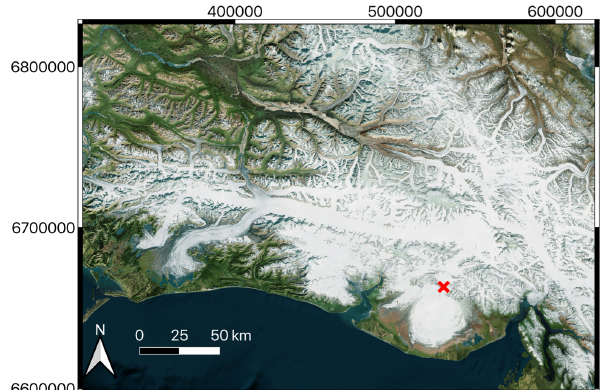
Figure 19. Optical image of the Malaspina Glacier in Alaska, where the red cross marks the location over the fast-moving glacier outlet for the validation of the velocity estimates against other prod- ucts. Background: © Microsoft Bing Maps